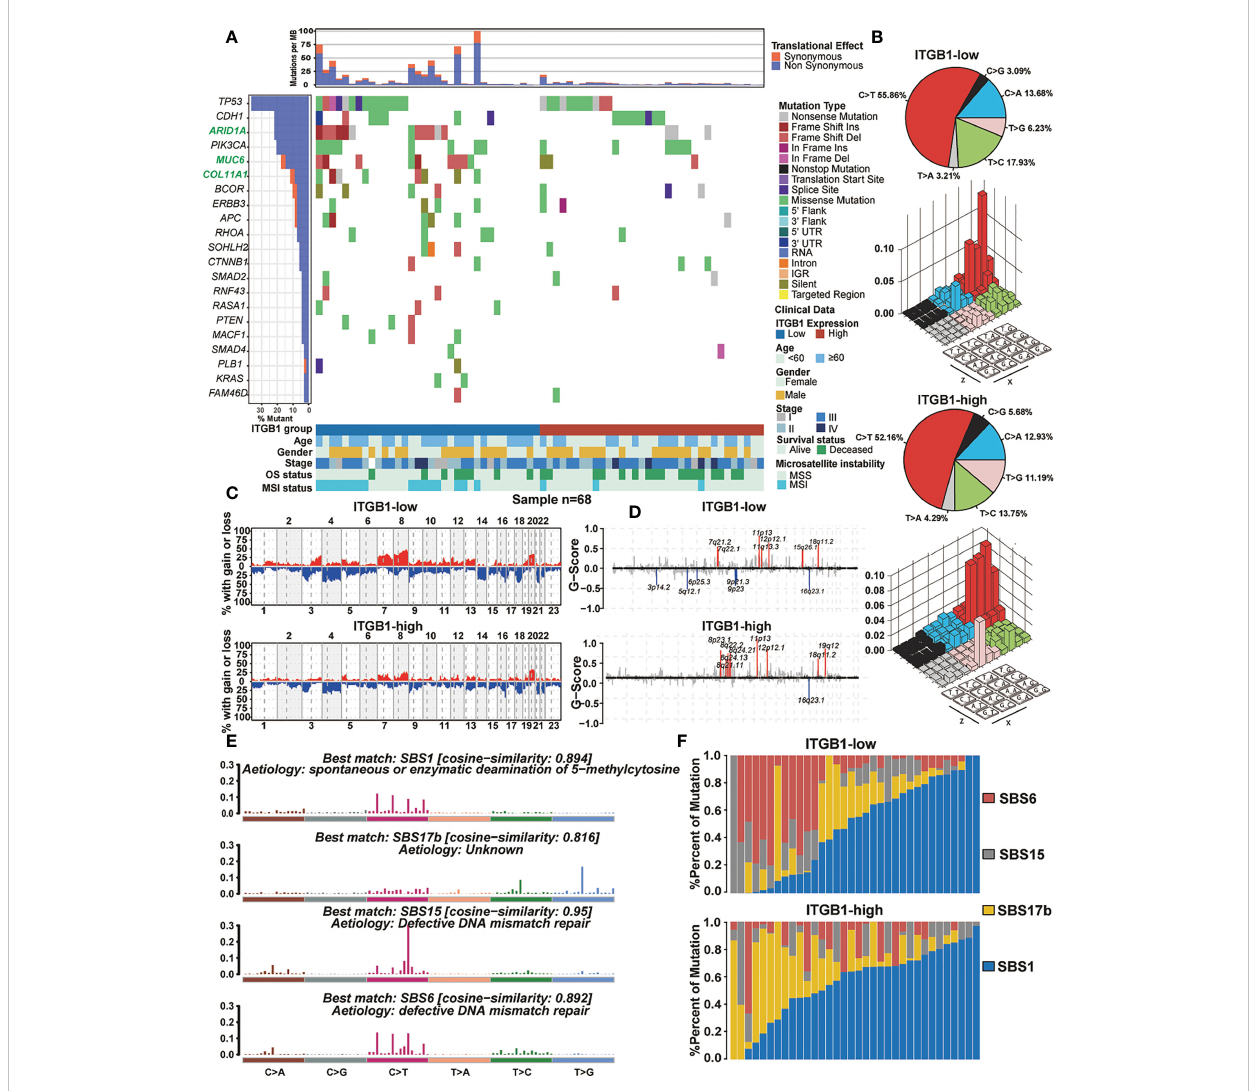
FIGURE 3 The mutational signature and the chromosomal copy number variation in DGC (A) Mutational landscape of signi fi cantly mutated genes in TCGA cohort were strati fi ed by the ITGB1-low and the ITGB1-high groups. The middle panel describes the mutation relation of signi fi cantly mutated genes across analyzed cases with mutation types color-coded differently. (B) Lego plot representation of mutation patterns in the ITGB1-low group and the ITGB1- high group. Single-nucleotide substitutions were divided into six categories with 16 surrounding fl anking bases. The pie chart in upper left showed the proportion of six sorts of mutation patterns. (C, D) The chromosomal copy number variation of somatic cell in the ITGB1-low and the ITGB1-high groups. The chromosome names were on the x-axes, whereas y-axes was the gain or loss of chromosome copy number mutation frequency in different ITGB1 groups. (E) The mutational activities of corresponding extracted mutational signatures (SBS1, SBS17b, SBS15 and SBS6). The trinucleotide base mutation types were on the x axes, whereas y axes showed the percentage of mutations in the signature attributed to each mutation type. (F) Mutational exposures (number of mutations) were attributed to each mutation signature. The percentage of mutations were on the y